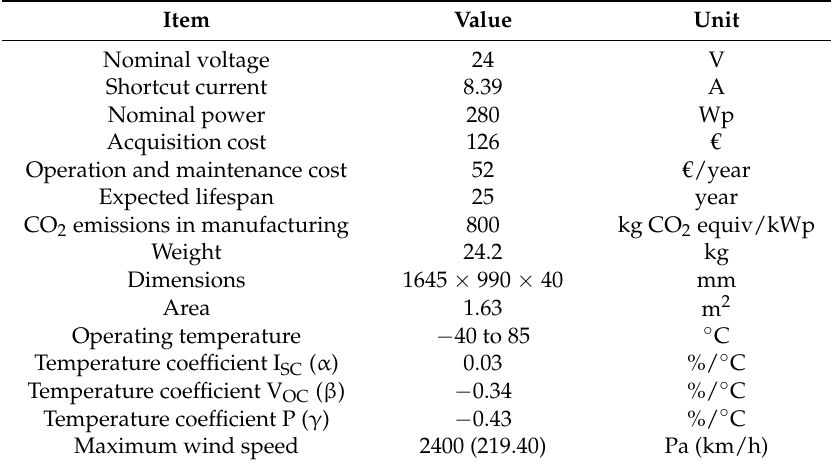
Table 2. Characteristics of photovoltaic (PV) panels